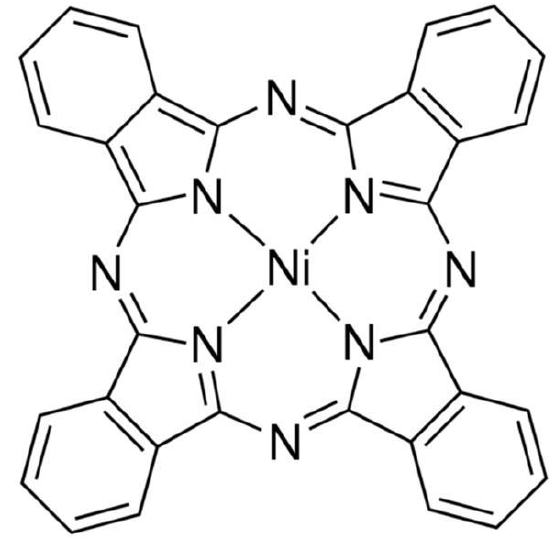
Figure 8. Molecular structures of NiPc.